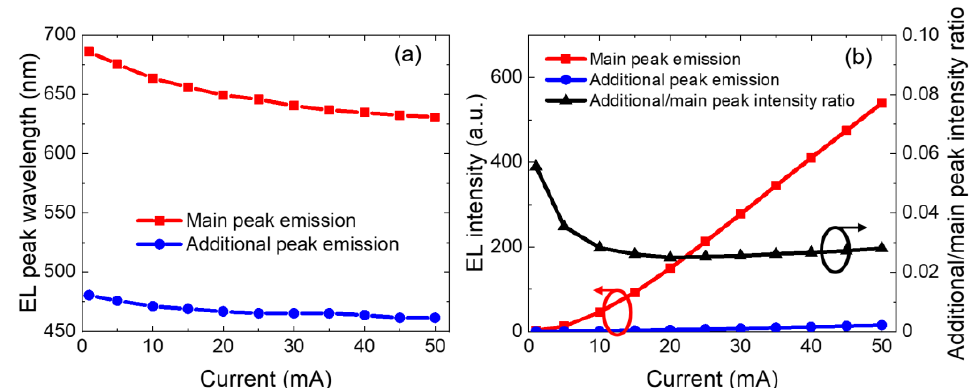
Figure 3. Current dependence of ( a ) the peak wavelengths, and ( b ) EL intensity and intensity ratio for additional short-wavelength and red quantum well (QW) emission.